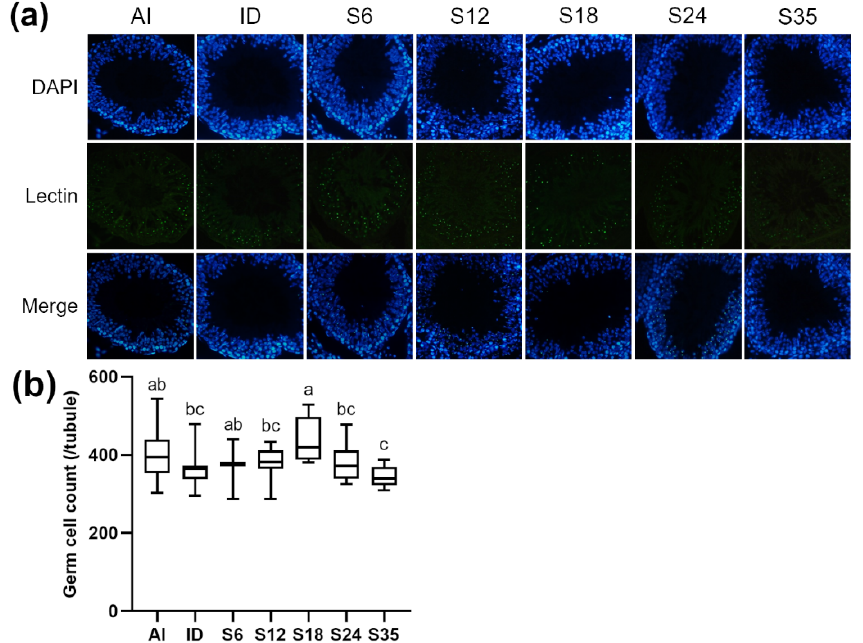
Figure 6. Effects of different doses of iron supplementation on ( a ) testicular seminiferous tubules by DAPI (nucleus) and Lectin (acrosome) staining, and ( b ) germ cell numbers in stage IV of spermatogenesis in iron-deficient rats. Values are presented as median (interquartile range, IQR). n = 4 per group. Values not sharing the same letters are significantly different at p < 0.05.